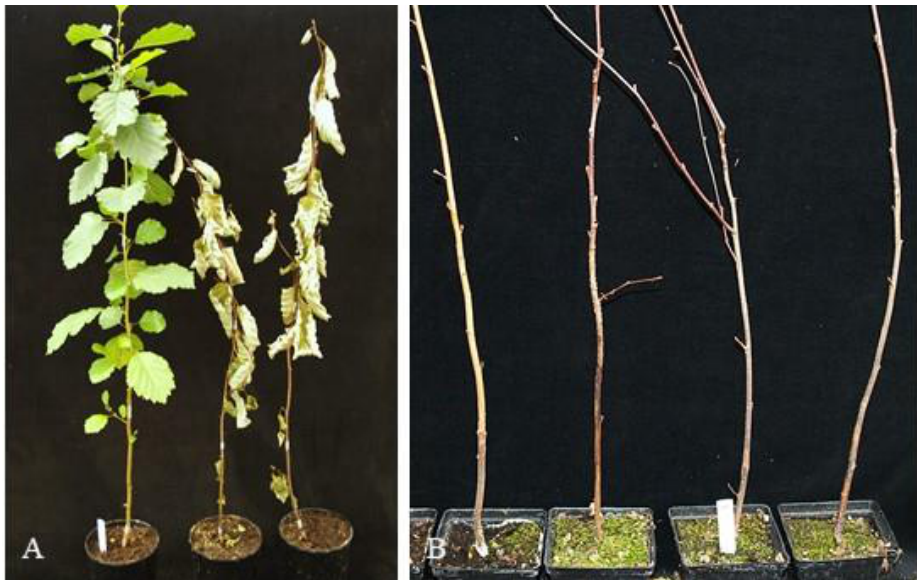
Figure 2. Colonization of shoots 2-year-old seedlings of Alnus glutinosa inoculated with Phytophthora × alni ( n = 15). Vertical bars at means showing SD. Tukey HSD — honestly significant difference cal- culated according to Tukey test at p = 0.05 for comparisons of the isolates group at each term of measurements.